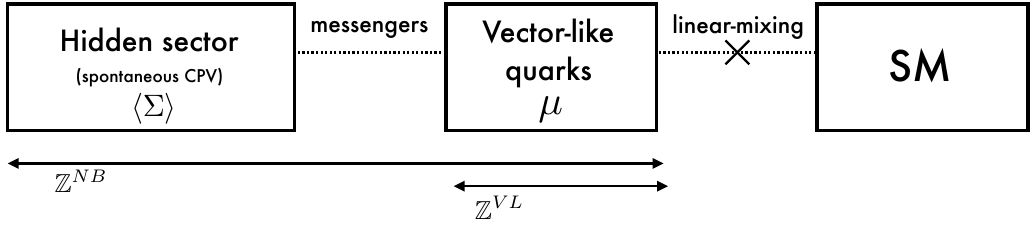
Figure 1 . Cartoon of the structure of Nelson-Barr solutions. The CP-symmetry is broken in a hidden sector that communicates to the vector-like quarks only. The latter are linearly mixed with the SM SU(2) singlet quarks (up and/or down) such that a the CKM phase is generated at tree L level while ¯ θ is suppressed. A set of (discrete) symmetries ensures the suppression of ¯ θ can act on both the hidden sector and the vector-like quarks ( Z NB in the cartoon) or on the vector like fermions only ( Z V L in the